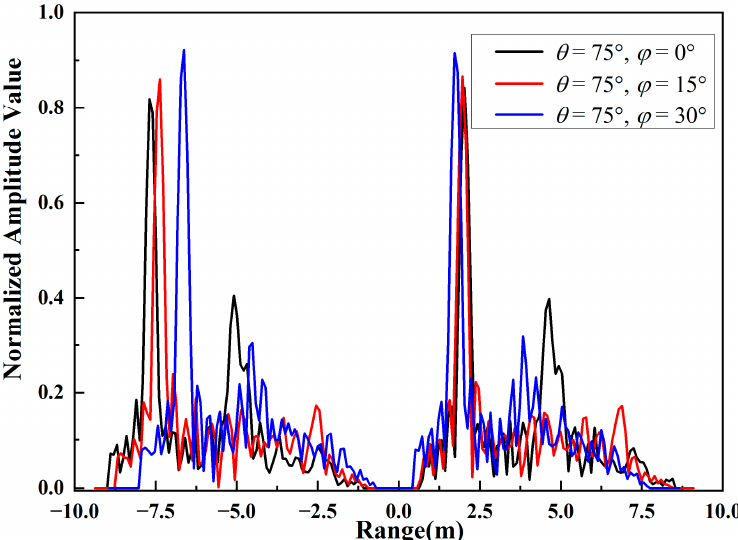
Figure 13. The HRRP of hybrid dielectric and conductor missile-like targets with different azimuth angles in the free space.